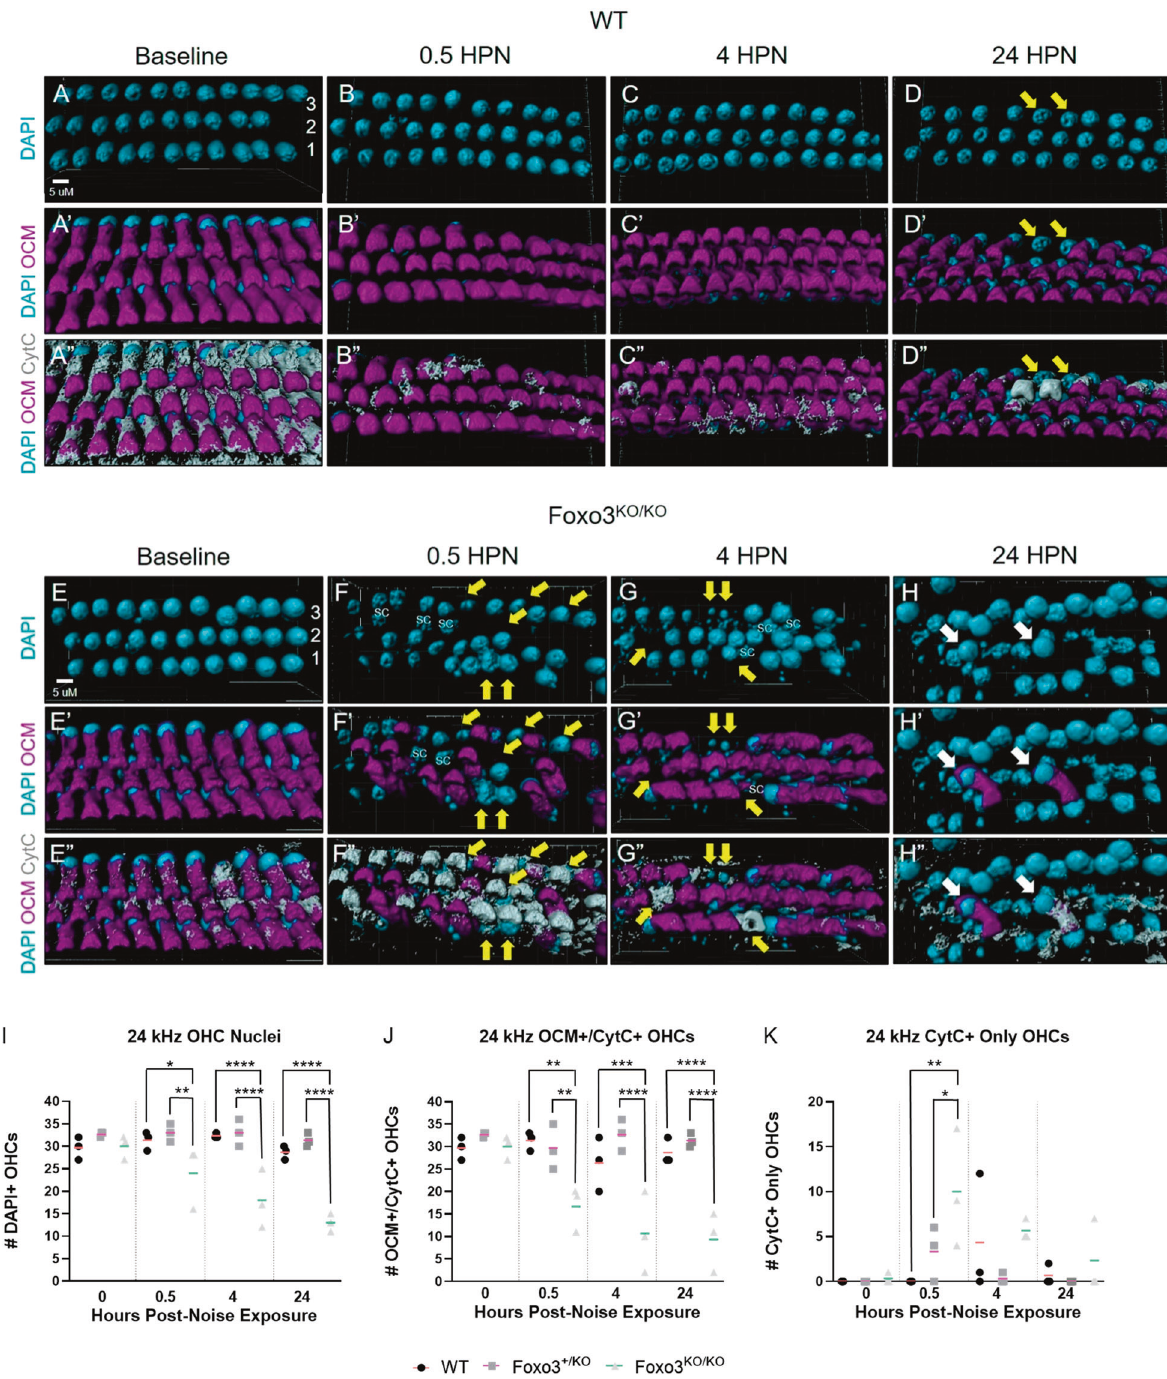
Fig. 2 Loss of OCM immunoreactivity precedes apoptosis in Foxo3 − / − OHCs. After immunostaining in whole-mount, the 24 kHz cochlear region was mapped, imaged using confocal microscopy at ×150 magni fi cation, and rendered in Imaris ( n = 3 cochleae per genotype/ condition). A – H The rendered images of OHCs colored cyan for DAPI + cell nuclei. A ’– H ’ Renderings of DAPI + /OCM + OHCs with OCM in magenta. A ″ – H ″ Renderings of DAPI + /OCM + /CytC + cells with CytC in gray. Scale bar = 10 µm. A – C ″ Little to no change in OCM and CytC localization through 4 HPN in WT OHCs. D – D ″ By 24 HPN, WT OHCs only expressing CytC + (yellow arrows) are in the minority of cells likely damaged by the noise exposure. F ′ , F ″ At 0.5 HPN, a large number of Foxo3 − / − OHCs lose OCM immunoreactivity (yellow arrows). G , G ″ By 4 HPN, several OHC regions with low OCM contain pyknotic or missing nuclei (yellow arrows). H ′ , H ″ Only two OCM + /CytC + OHCs remain in any of the standard three rows (white arrows); the other nuclei belong to SCs as they exist in a lower z -plane and have a larger mean diameter. I – K OHC counts for all three genotypes expressing speci fi c fl uorophores ( y -axis) are graphed versus the noise exposure timeline ( x -axis). I Numbers of DAPI + OHC nuclei ( y -axis) present across the time course ( x -axis); supporting cell nuclei unable to be excluded in the renderings due to thresholding limitations were omitted. J Counts of OHCs as calculated by totaling OCM + /CytC + cells ( y -axis). K Counts of OHCs only expressing CytC ( y -axis). WT (black circles, orange mean bar), Foxo3 + / − (gray squares, pink mean bar), and Foxo3 − / − (light gray triangles, green mean bar) total cell counts per 1024 × 400 × 20-pixel selection. n = 3 per genotype/condition, two-way ANOVA with Tukey ’ s test for multiple comparisons, alpha = 0.05, * p < 0.05, ** p < 0.01, *** p < 0.001, **** p <